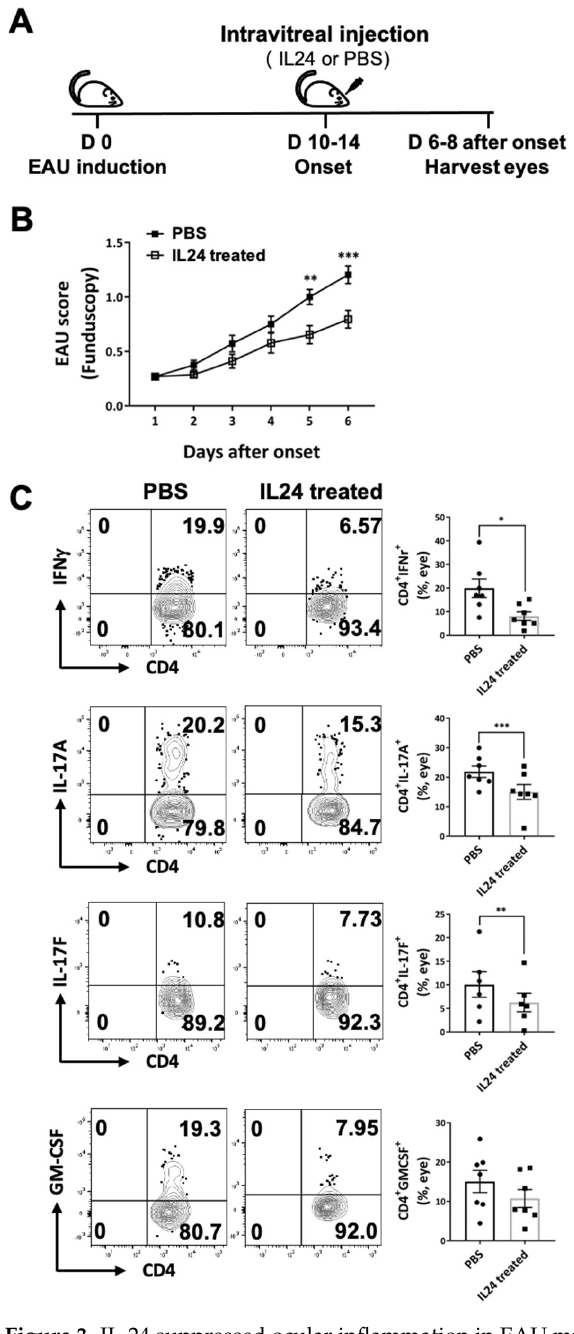
Figure 3. IL-24 suppressed ocular inflammation in EAU mice. EAU was induced in C57BL/6 mice by active immunization with IRBP 1-20 and CFA. ( A ) Each of the eyes was injected intravitreally with either recombinant IL-24 or PBS on the day of disease onset. Eyes were harvested on day 6-8 after onset. ( B ) EAU disease score was determined by funduscopy. Eyes treated with recombinant IL-24 developed significantly lower disease than the controls. Compiled data from three independent experiments, means ± SEMs (PBS: n = 14 eyes, IL-24 treated: n = 14 eyes). ** p < 0.05, *** p < 0.001, Two-way ANOVA. ( C ) Representative FCM plot (left) and compiled data (right) of IFN- γ , IL-17A, IL-17F, and GM-CSF production of ocular-infiltrating CD4 + T cells on day 6–8 after onset. Compiled data from two independent experiments (PBS: n = 7 eyes, IL-24 treated: n = 7 eyes). Means ± SEMs, * p < 0.05, ** p < 0.05, *** p < 0.001, paired t -test.